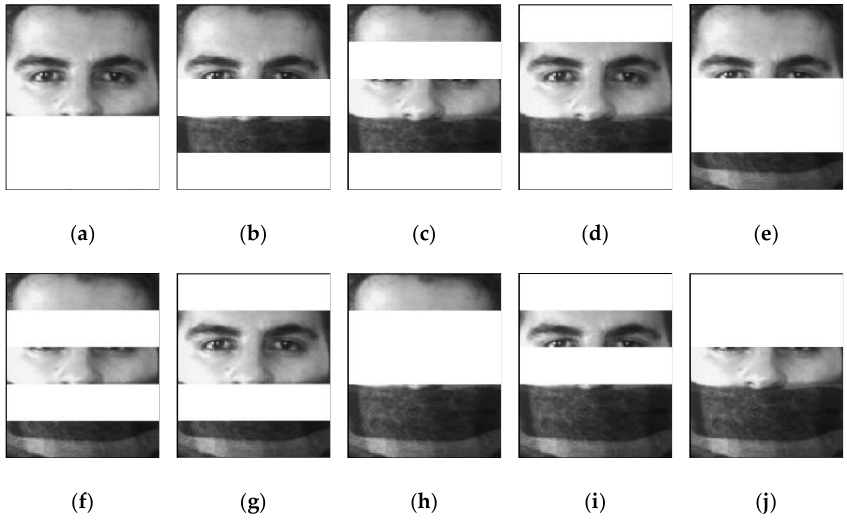
Figure 7. Arrangement and combination scheme of a certain test sub-image (involving a scarf) in